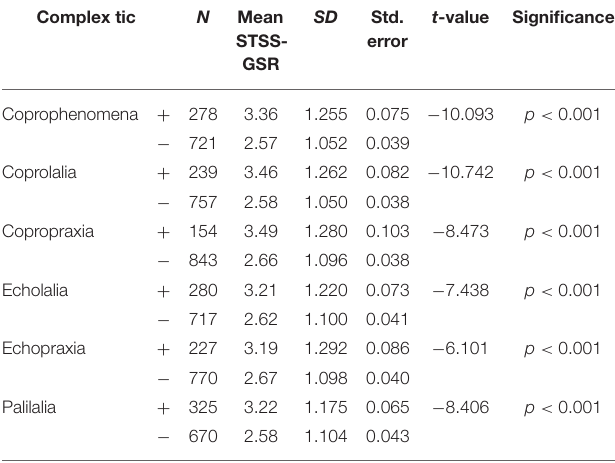
* according to STSS-GSR. STSS-GSR, Global Severity Rating of the Shapiro Tourette-Syndrome Severity Scale; N, number of cases; SD, standard deviation; Std.,